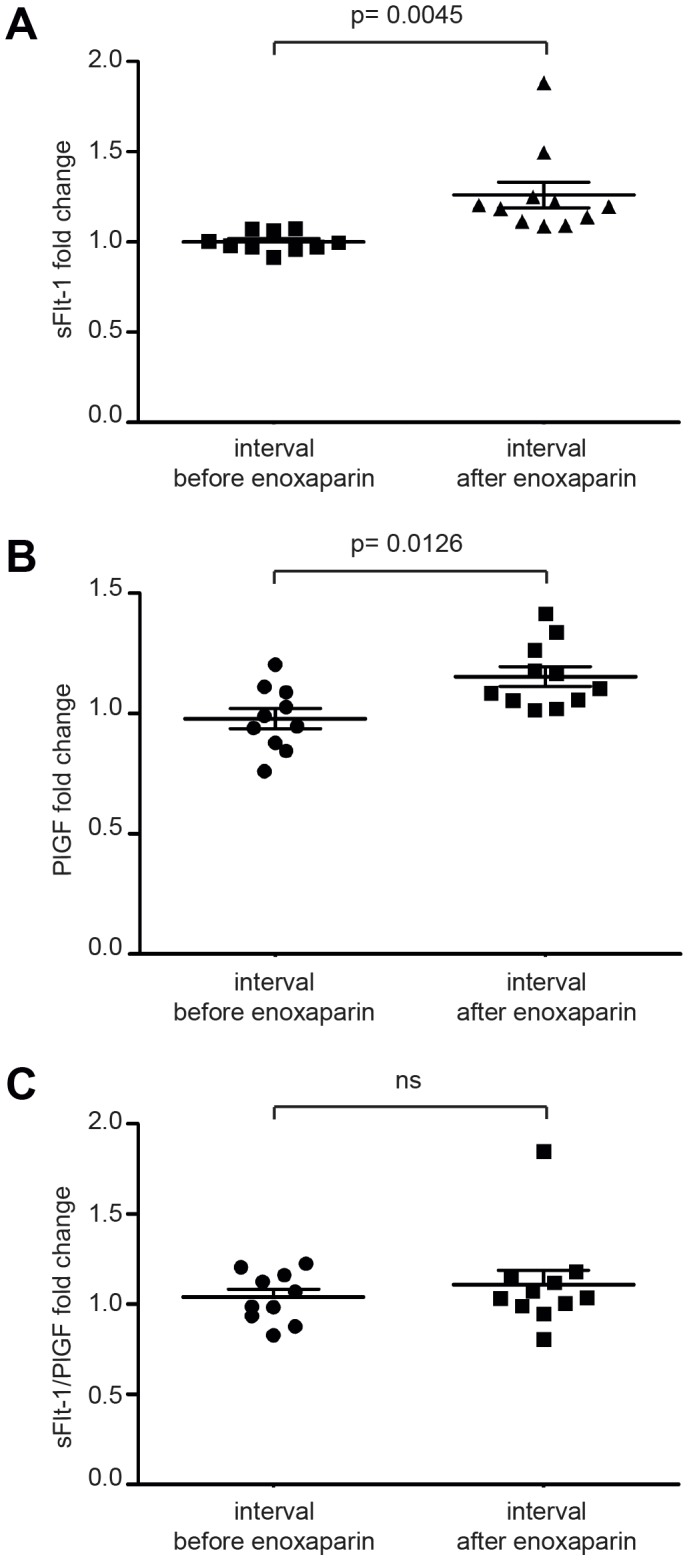
sFlt-1 and PlGF serum levels increase after the administration of low molecular weight heparin.2-1 levels increase to 1.26 fold on average (95% CI (interval before LMWH) 0,9627–1,040; 95% CI (interval after LMWH) 1.103–1.418; p = 0.0045) (A), PlGF levels increase to 1.15 fold on average (p = 0.0126) (B), the resulting increase of sFlt-1/PlGF ratio does not reach statistical significance (C).